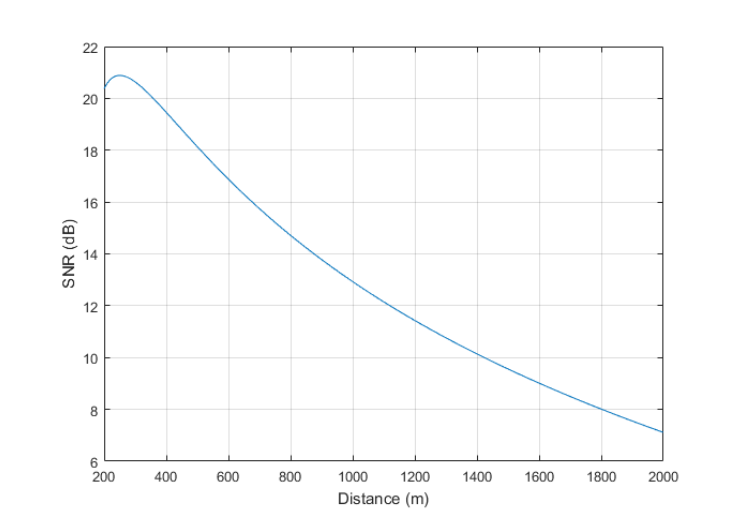
Figure 8. SNR as a function of the distance from the target.